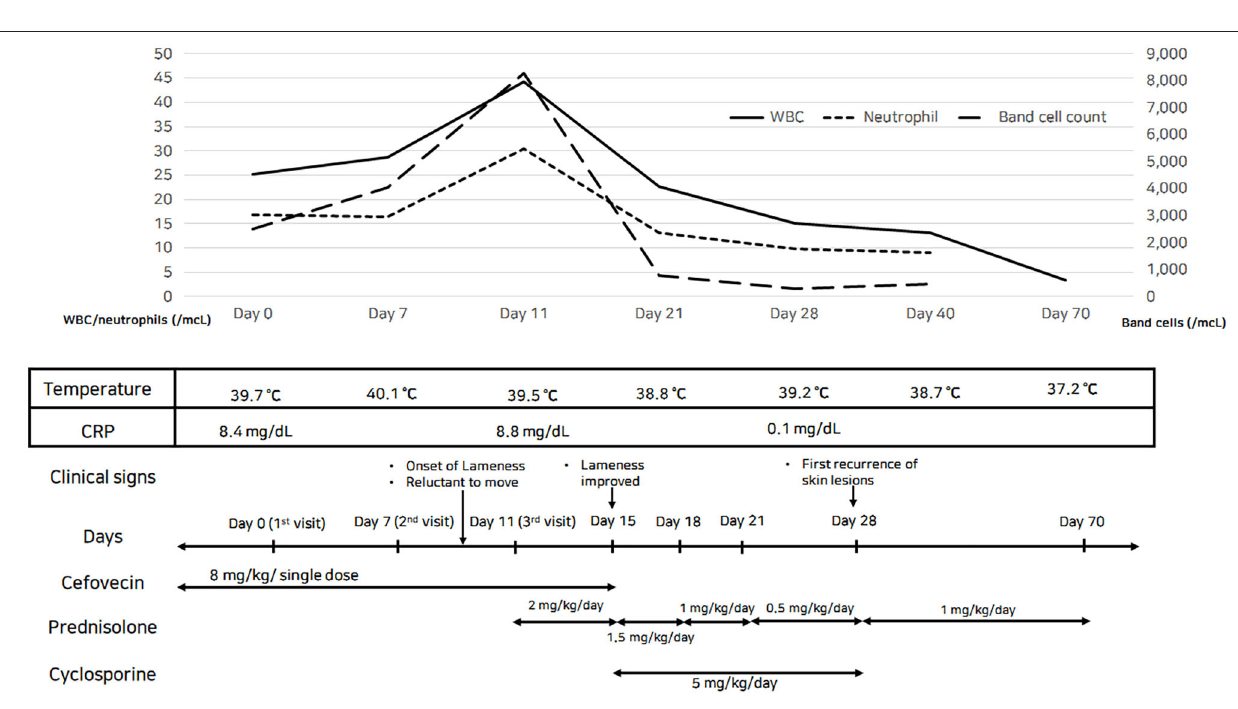
FIGURE 3 | Timings of laboratory data and therapeutic trials of the dog with sterile neutrophilic dermatosis. Increased WBC count and band cell count with persistent fever indicated worsening systemic inflammation; these signs were absent after starting the steroid